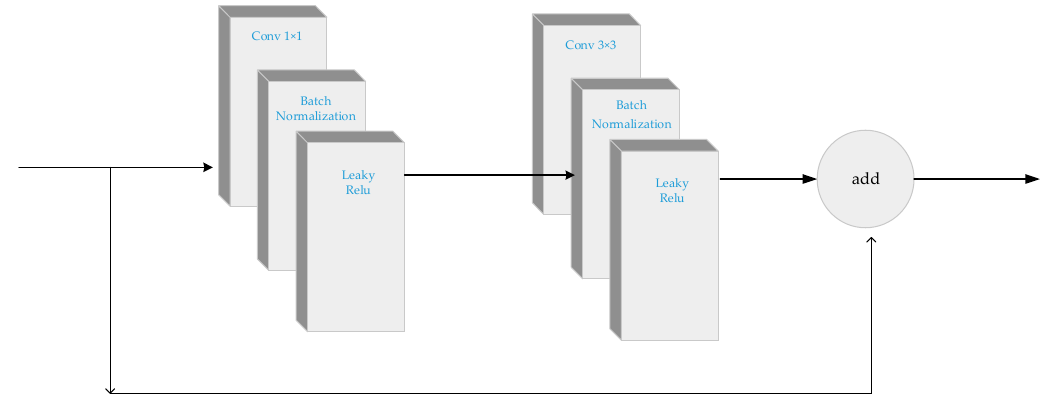
Figure 2. The structure of the residual unit .